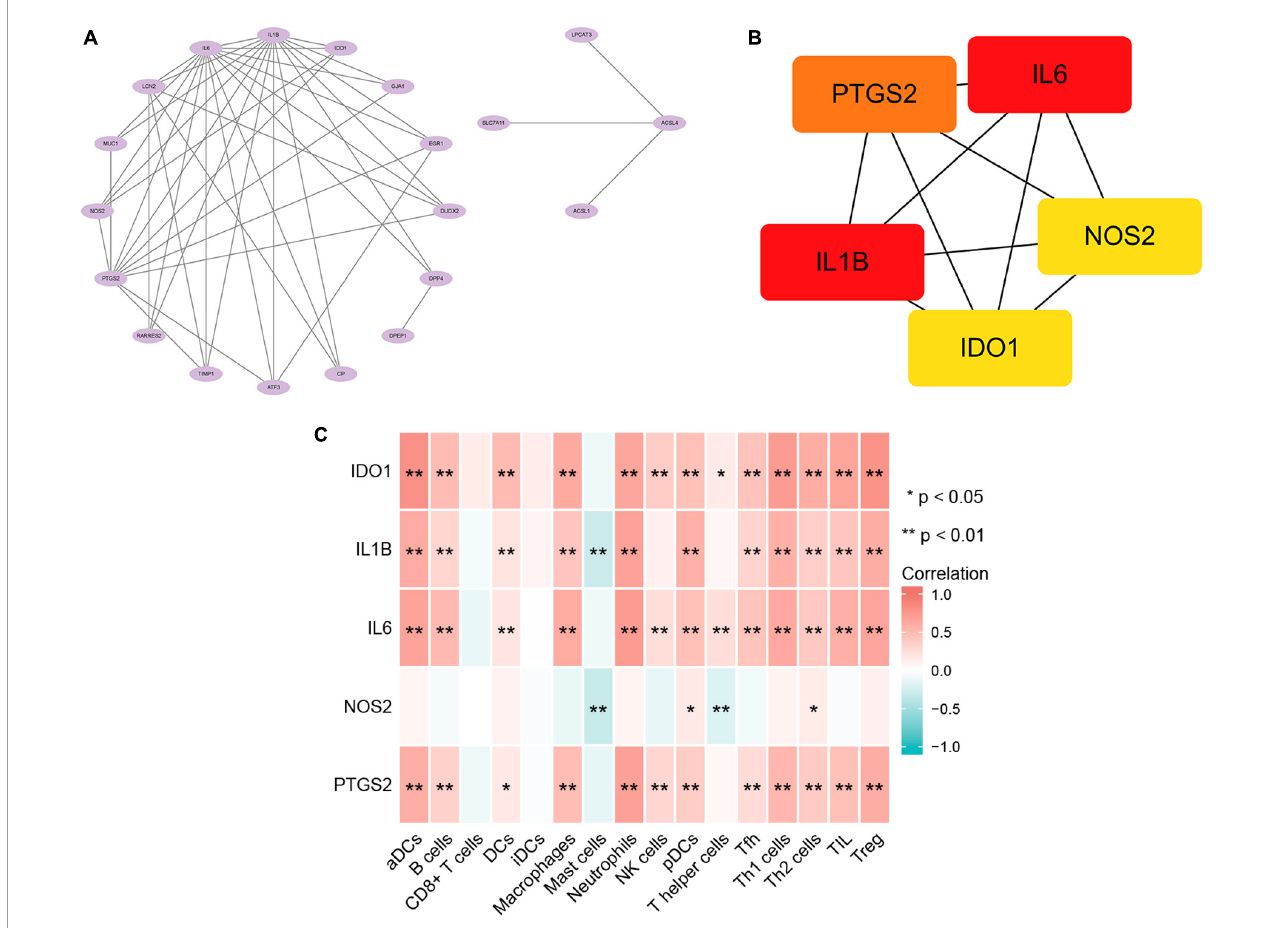
FIGURE4 Protein-protein interaction network (PPI) and immune infiltration analysis. (A) Visual analysis of ferroptosis-associated genes. (B) cytoHubba screening of hub genes. (C) Correlation analysis of immune